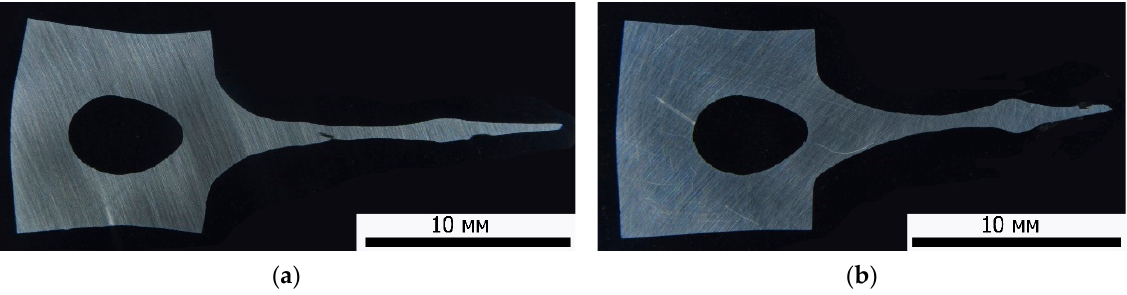
Figure 5. Specimens after superplasticity tests: ( a ) alloy No. 2 (500 °C, 1 × 10 − 3 s − 1 ); ( b ) alloy No. 5 (500 °C, 3.3 × 10 − 4 s − 1 ).